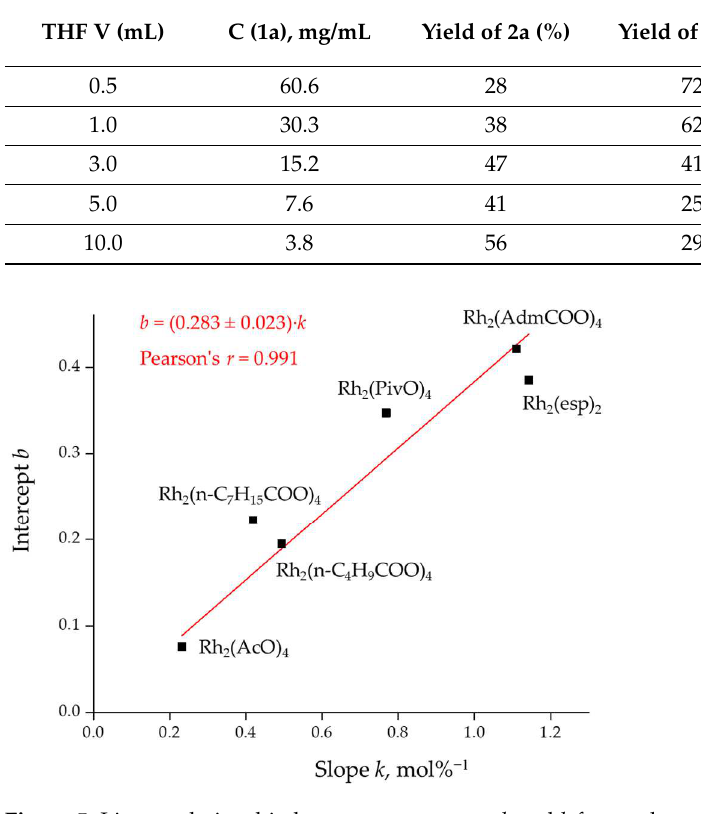
Table 2. Outcome of 1a → 2a + 3a reaction performed at different dilutions.